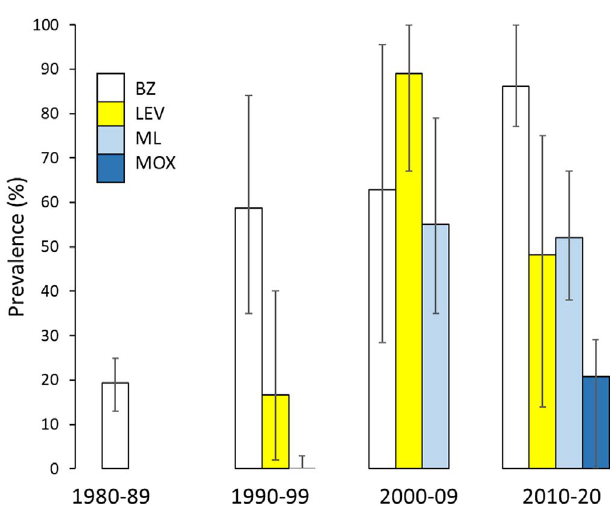
Figure 5. Average farm-level prevalence of anthelmintic resistance in gastrointestinal nematodes in sheep and goats, by decade. The arithmetic mean was taken of all reports including more than one farm, from countries with a minimum of three reports in different years, excluding Italy (see text). BZ = benzimidazoles, n = 64; LEV = levamisole, n = 14; ML = macrocyclic lactones excluding moxidectin, n = 23; MOX = moxidectin, n = 10. Error bars are standard deviations.